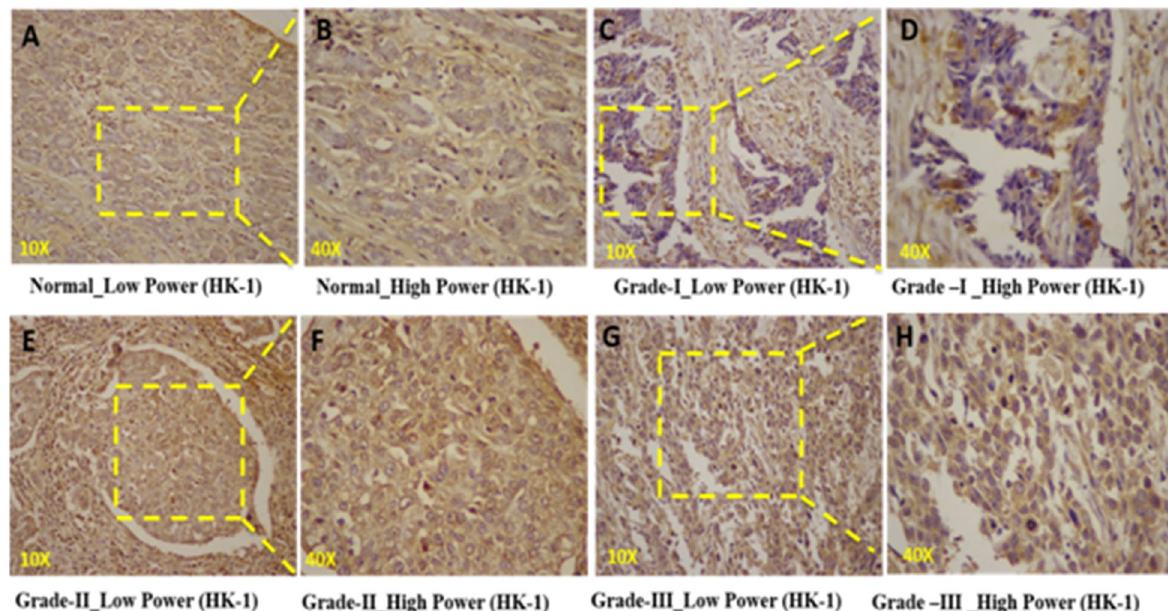
Fig. 4 Immunohistochemical expression of HK-I with increasing grade in breast carcinoma. The expression of HK-I was mostly cytoplasmic. A Normal tissue (10X), B Normal tissue (40X), C Grade I(10X), D Grade I(40X), E Grade II(10X), F Grade II(40X), G Grade III(10X), H Grade III